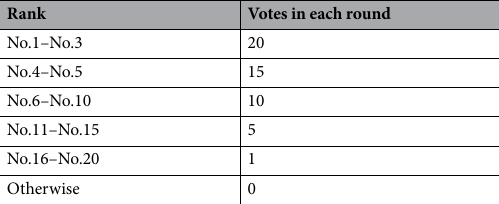
where m 1 and m 2 were the 2-dimensional sample mean of HCC and adjacent non-tumor tissues for combined projection or the 2-dimensional sample mean of column vectors representing combined projection values on a miRNA pair for dimension reduction projection, respectively. S w was called the within-class scatter matrix, and was given by, = where x denoted a 2-dimensional sample from HCC or adjacent non-tumor tissues for combined projection or a 2-dimensional sample from combined projection values for dimension reduction projection. n 1 and n 2 were the numbers of samples that represented metastasis-free and metastasis samples with n 1 = 102 and n 2 = 29. Detail formula derivation could be seen in Duda’s book 25 . The Fisher’s LDA-based classification was based on the opti- mal decision boundary with its equation w t x + w 0 = 0, where w 0 was given by = + w . x was regarded as a non-metastasis sample when w t x + w 0 < 0, and vice versa. Therefore, the error rate that wrongly classified x into the non-metastasis group was defined as = + , and the error rate that 1 . Considering that the sample size wrongly classified x into the metastasis group was = + < Er w #{ 2 was not balanced between the two phenotype groups, the classification error rate was defined as Er = ( Er 1 + Er 2 )/2. A permutation test based on univariate Welch’s t-test. We tested combined projection values of each individual of probes or dimension reduction projection values of each pair of probes using Welch’s t-test, which was expressed as, υ